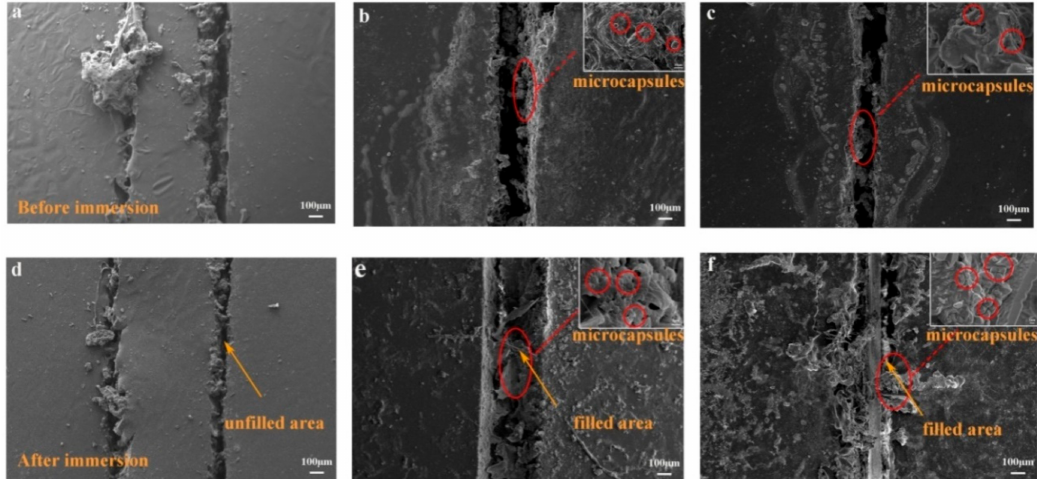
Figure 10. SEM morphology of the scratched coatings with di ff erent contents of microcapsules before and after immersion in seawater for 366 h (( a , d ) pure epoxy coatings; ( b , c ) embedded with 2.0 wt% microcapsules; ( c , f ) embedded with 5.0 wt%